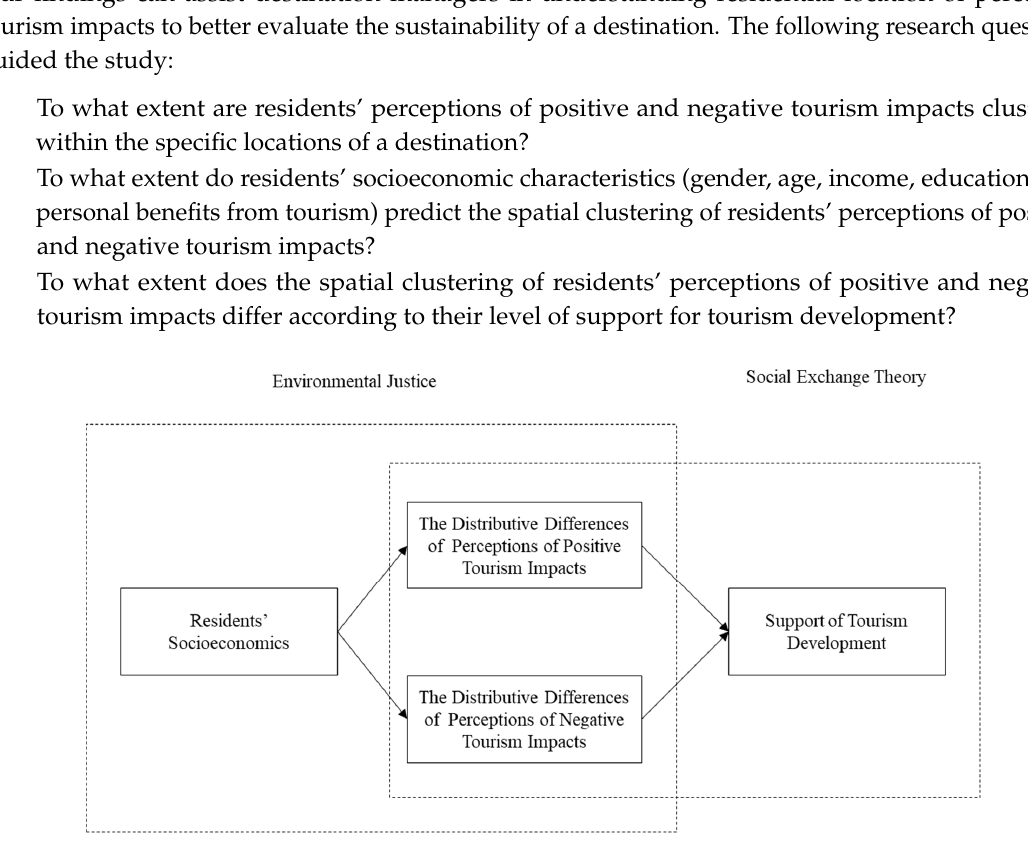
Figure 1. Proposed framework for the